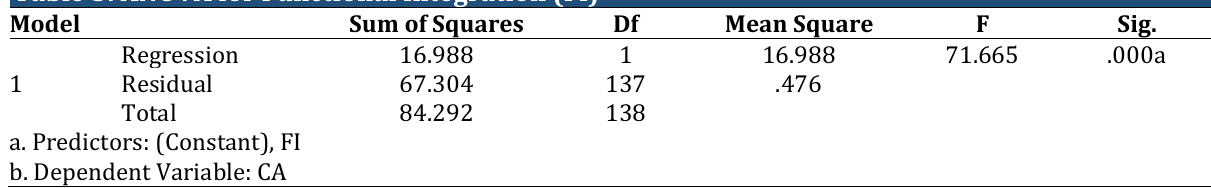
Table 5: ANOVA for Functional Integration (FI) Model